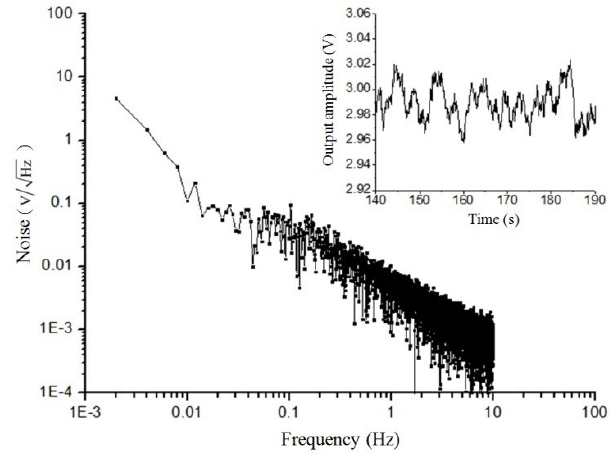
Figure 12. Test result of the noise power spectral density.